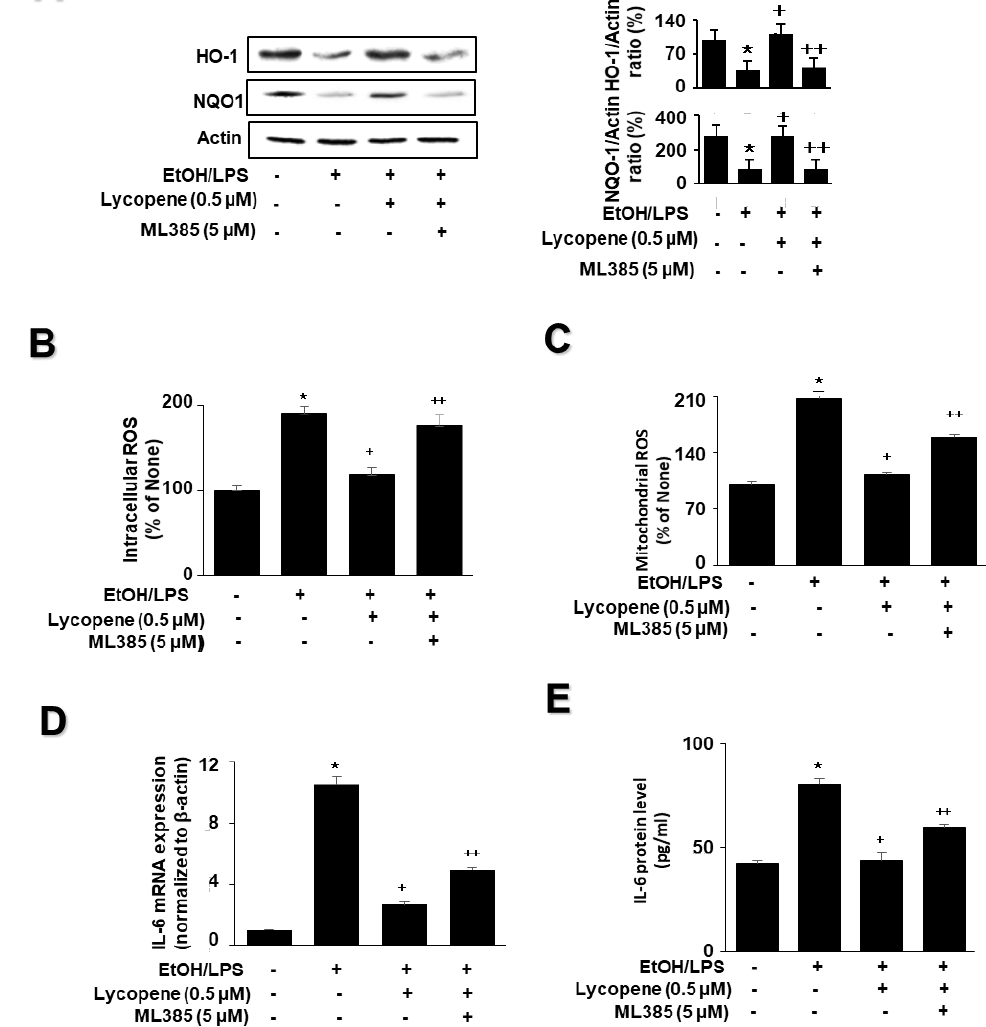
Figure 5. Effect of the Nrf2 inhibitor ML385 on the levels of HO-1, NQO1, ROS, and IL-6 in ethanol (EtOH)/lipopolysaccharide (LPS)-stimulated and lycopene-treated AR42J cells. The cells (1 × 10 6 /10 mL/dish or 2 × 10 5 /2 mL//well) were pretreated with ML385 (5 μM) in the presence of lycopene (0.5 μM) for 1 h and stimulated with EtOH (at a final concentration of 250 mM)/LPS (10 μg/mL) for 30 min ( A ), 6 h ( B ), or 24 h ( C ). ( A ) Protein levels of NQO1 and HO-1 in whole-cell extracts were deter- mined by western blot analysis, with actin as the loading control ( left panel ). The densitometry analysis-derived ratios of HO-1/actin and NQO1/actin in whole-cell extracts represent mean ± S.E. from three immunoblots. The ratio of control cells (cells not treated with EtOH/LPS or lycopene) was set at 100% ( right panel ). ( B ) Intracellular ROS levels were determined by DCF fluorescence. ( C ) Mitochondrial ROS levels were measured by determining the level of fluorescent MitoSOX. The value for ROS levels in control cells (cells not treated with EtOH/LPS, lycopene, or ML387) was set at 100%. ( D ) mRNA expression of IL-6 was determined by real-time polymerase chain reaction and normalized to that of β -actin. The IL-6 mRNA level in control cells (cells not treated with EtOH/LPS, lycopene, or ZnPP) was set as 1. ( E ) IL-6 levels in the medium were measured by enzyme-linked immunosorbent assay. Data are expressed as the mean ± SE ( n = 12 in each group). * p < 0.05 vs. control cells (cells not treated with EtOH/LPS, lycopene, or ML387); + p < 0.05 vs. cells with EtOH/LPS stimulation and without any treatment; ++ p < 0.05 vs. cells with EtOH/LPS stimulation and lycopene treatment. The cells incubated with tetrahydrofuran (THF, 0.01%) alone served as a vehicle control. For each experiment, lycopene-untreated cells received a vehicle THF (0.01%) alone instead of lycopene. ML385 was dissolved in dimethyl sulfoxide (DMSO). For each experiment, ML385-untreated cells received a vehicle DMSO (0.05%). +, treatment.